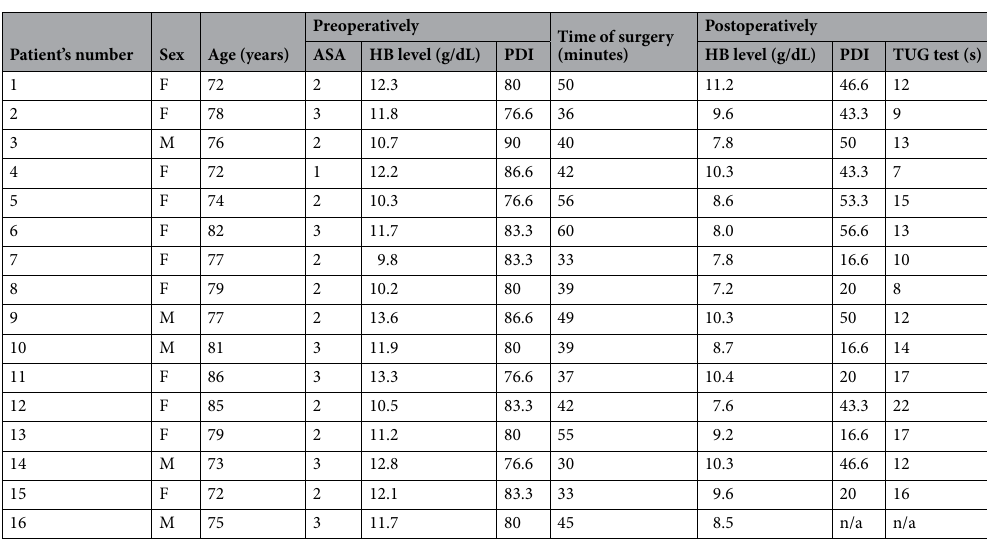
Table 1. Detailed data gathered within the present study. ASA, American Society of Anaesthesiologists classification; HB, haemoglobin; n/a, not applicable; PDI, Pelvic Discomfort Index; TUG. Timed Up and